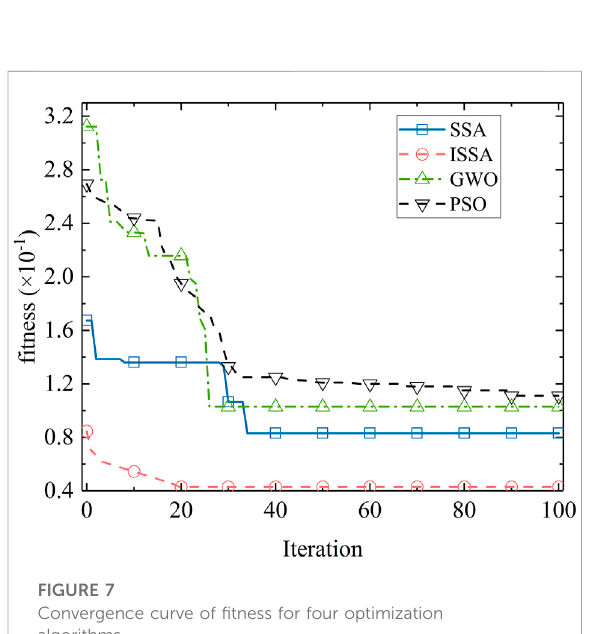
FIGURE 8 The comparison of inversion temperature and test temperature of BPNN improved by swarm intelligence